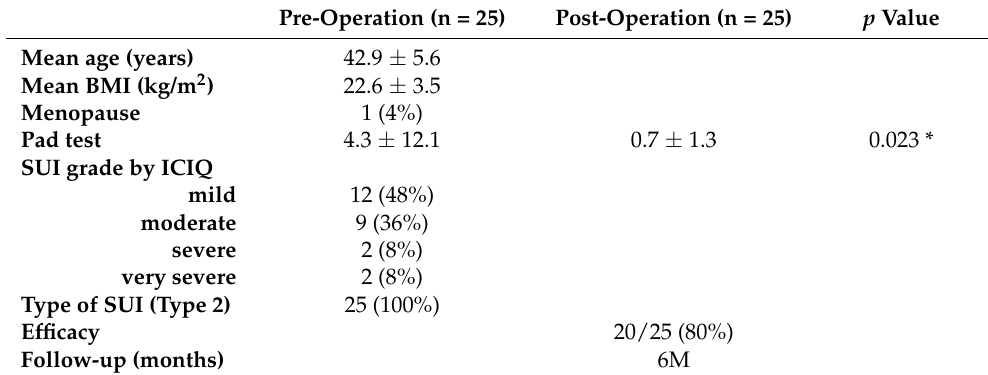
Table 1. Clinical background of the participants. Data are given as mean ± standard deviation or n (%).